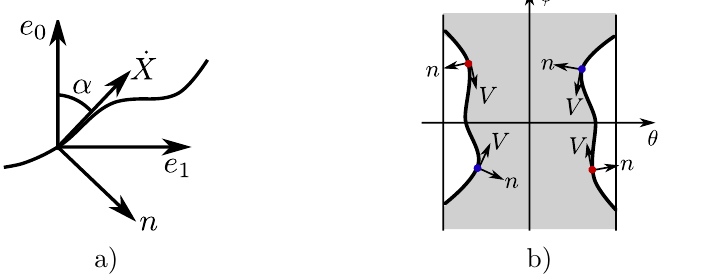
Figure 2 . a) De(cid:12)nition of angle (cid:11) in (2.2). b) Red particles have K = (cid:20) , and blue particles K = (cid:0) (cid:20)